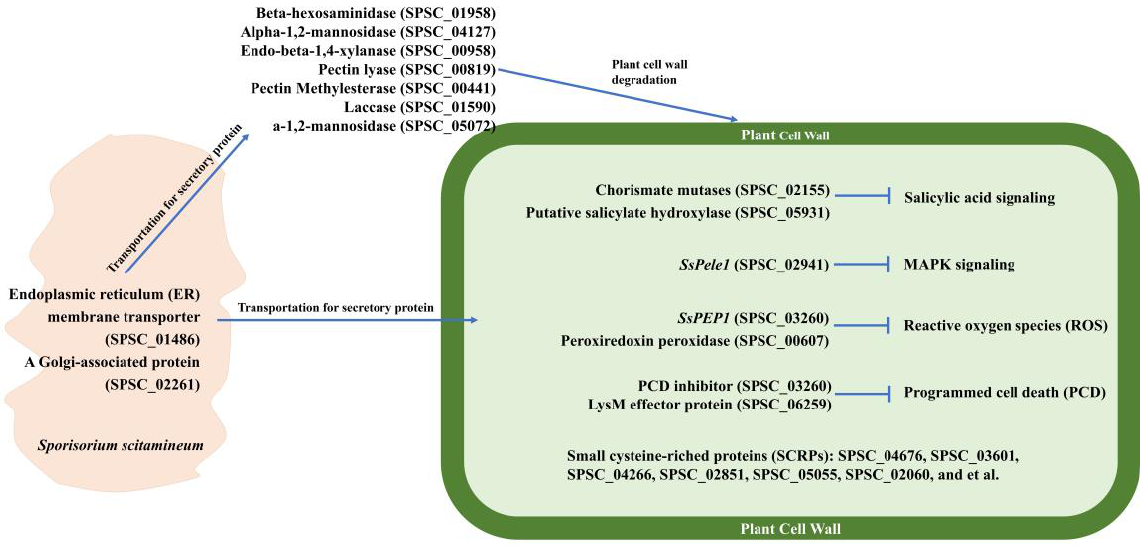
Figure 8. A working model of S. scitamineum proteins in infection. The model was postulated based on current findings combined with the results of PHI database BLASTp and SCRPs prediction in MEpurple and MEdarkturquoise modules. The representative proteins with different mechanisms of S. scitamineum infection were chosen in this model. The expression profiles of these genes were shown in Figures 6 and 7. The functions of the listed proteins were assumed by annotation. The functions of the predicted SCRPs remained unknown.